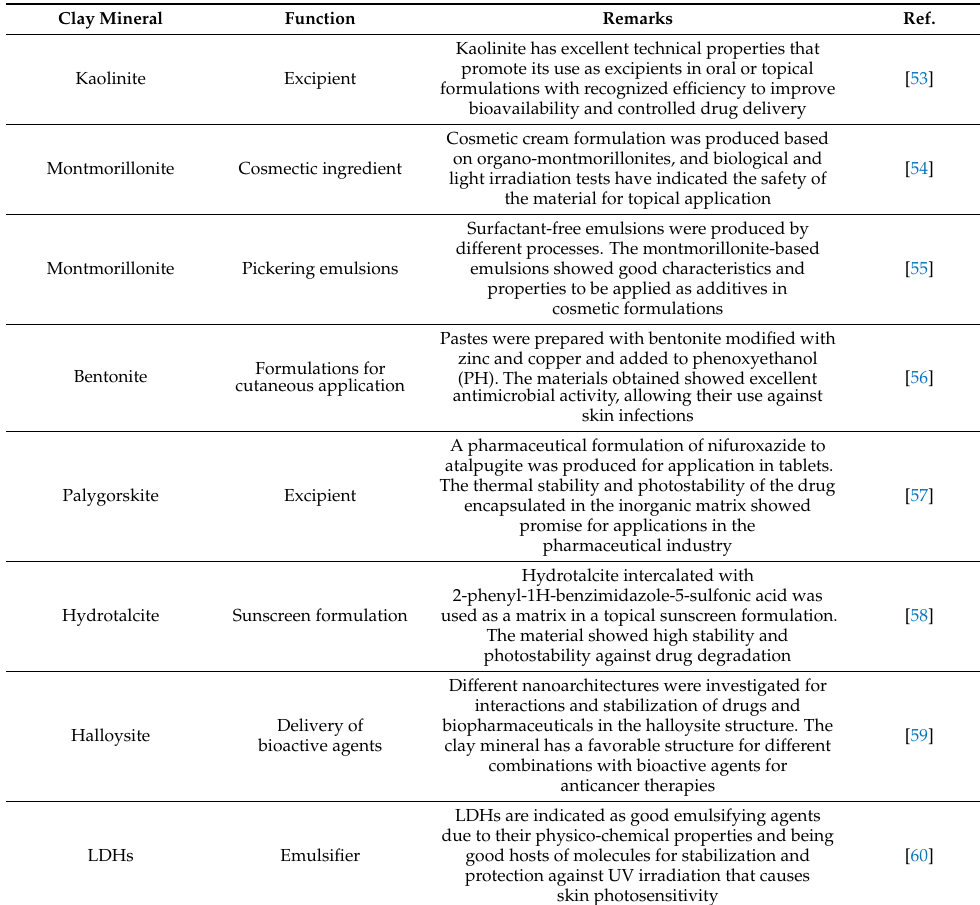
Table 1. Some clay minerals used to stabilize drug-based products in oral or topical